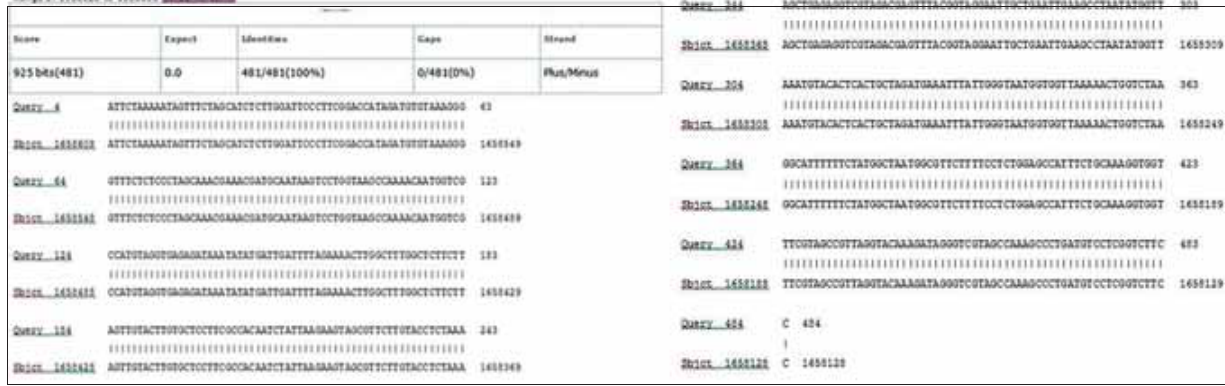
Figure-3: Sequence analysis of the isolate of Riemerella anatipestifer with R. anatipestifer RA-CH-2, complete genome, published in